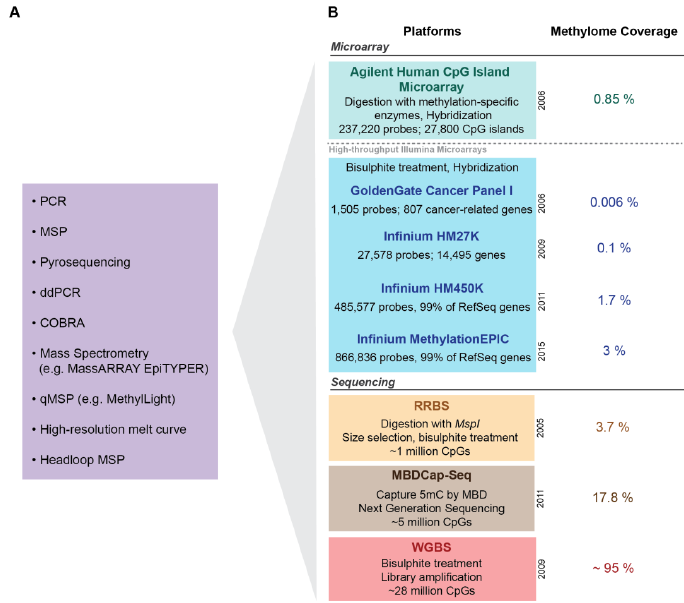
Figure 2. Methylation profiling approaches for biomarker discovery and validation. ( A ) Candidate gene approaches: Targeted candidate gene approaches used in a priori studies and for the validation of novel candidate markers. ( B ) Genome wide approaches: Microarray and sequencing-based genome-wide approaches used for the discovery of novel biomarkers—comparison of the methodology, number of CpGs (cytosine-guanine dinucleotides) and / or genes targeted and coverage of the methylome across the di ff erent platforms. RefSeq: Reference Sequences; PCR: polymerase chain reaction; MSP: methylation-specific PCR; ddPCR: droplet digital PCR; COBRA: combined bisulphite restriction analysis; qMSP: quantitative methylation-specific PCR; HM: human methylation; RRBS: reduced representation bisulphite sequencing; MBDCap-Seq: methyl-CpG binding domain capture sequencing; WGBS: whole genome bisulphite